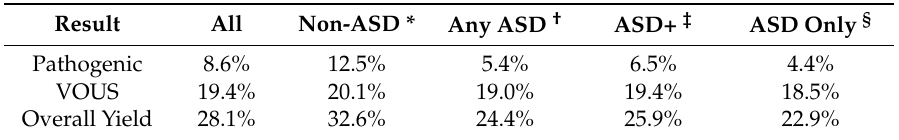
Table 3. Diagnostic yields of genetic testing in 10,351 consecutive children with neurodevelopmental disorders by diagnostic referral codes.